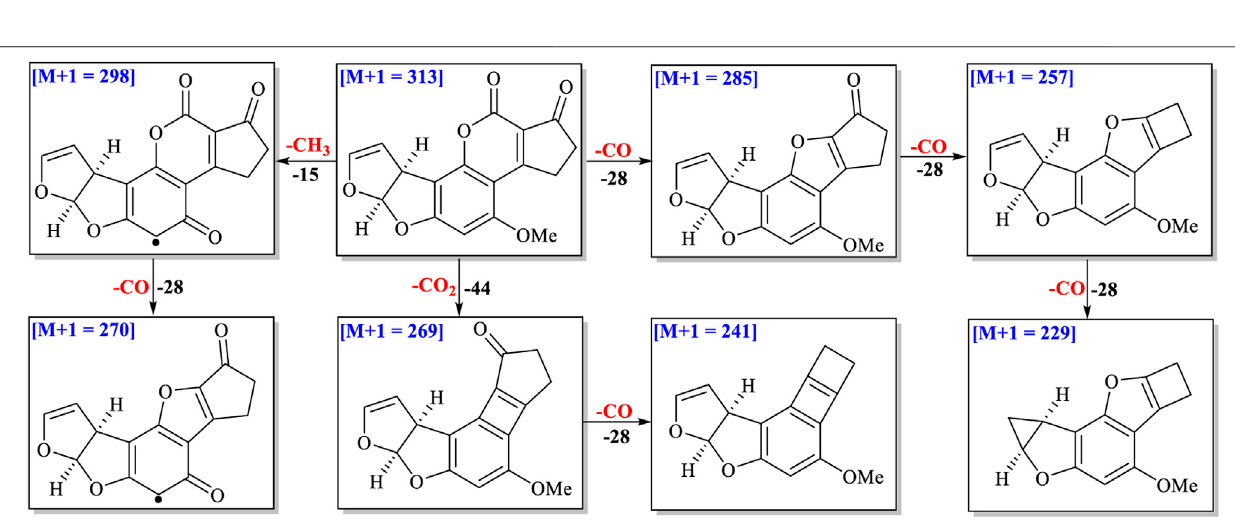
FIGURE 3 | Fragmentation pathway of AFB 1